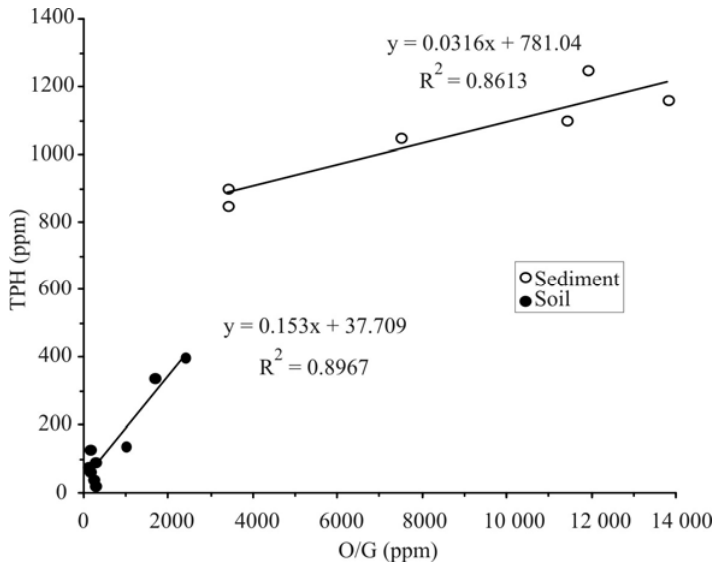
Fig. 1. Correlation between total petroleum hydrocarbon (TPH) and oil/grease (O/G) in soil and sediment samples